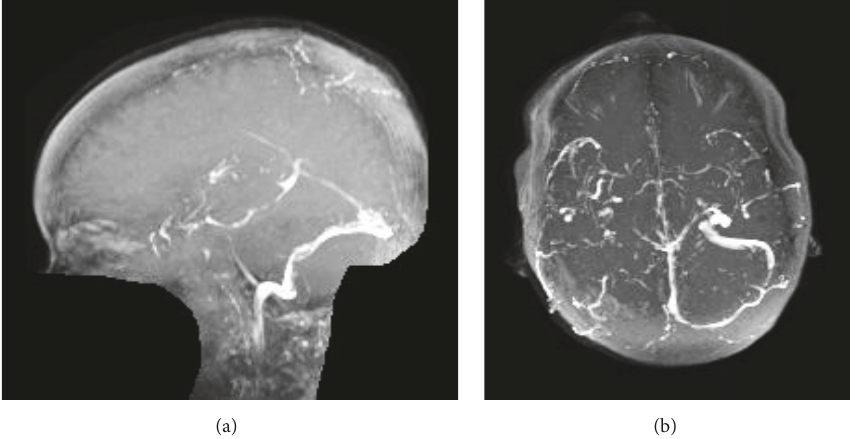
Figure 2: MRV of the head without contrast revealed a lack of flow in the superior sagittal sinus (a), as well as right transverse and sigmoid sinuses